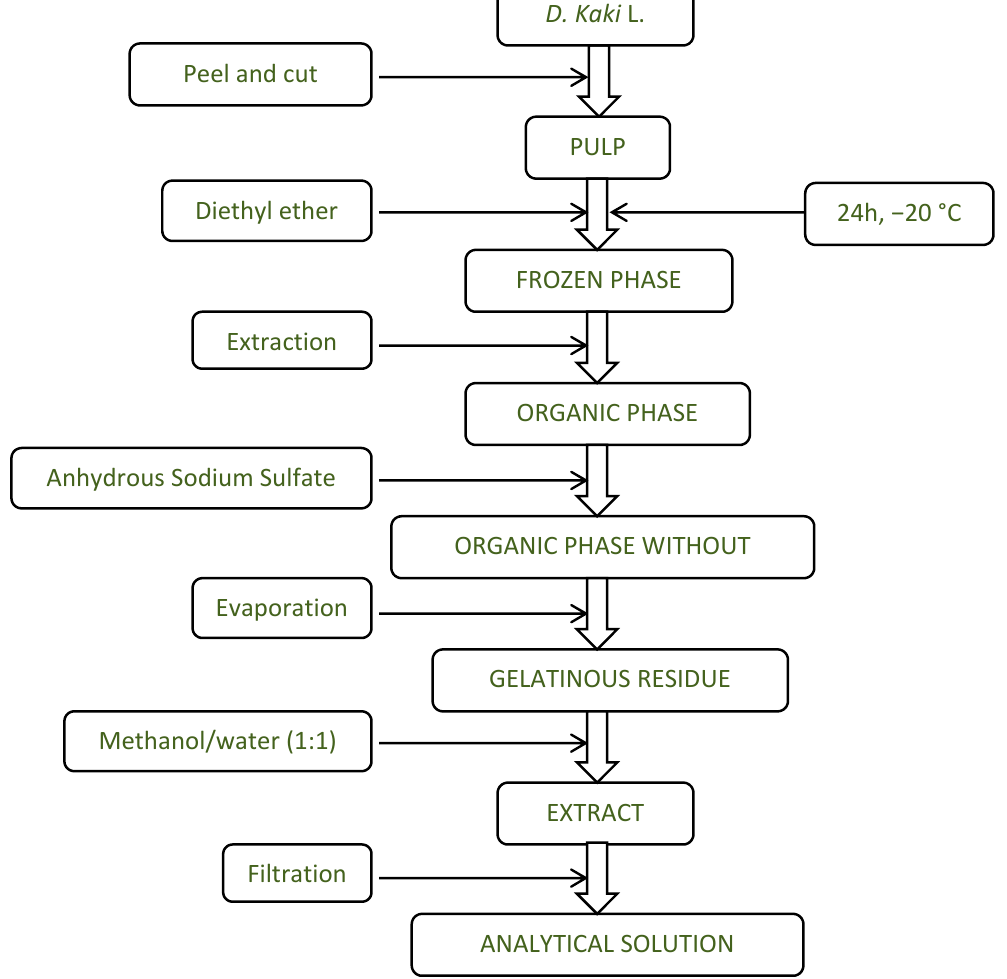
Figure 1. Schematic process of the extraction of phenolic